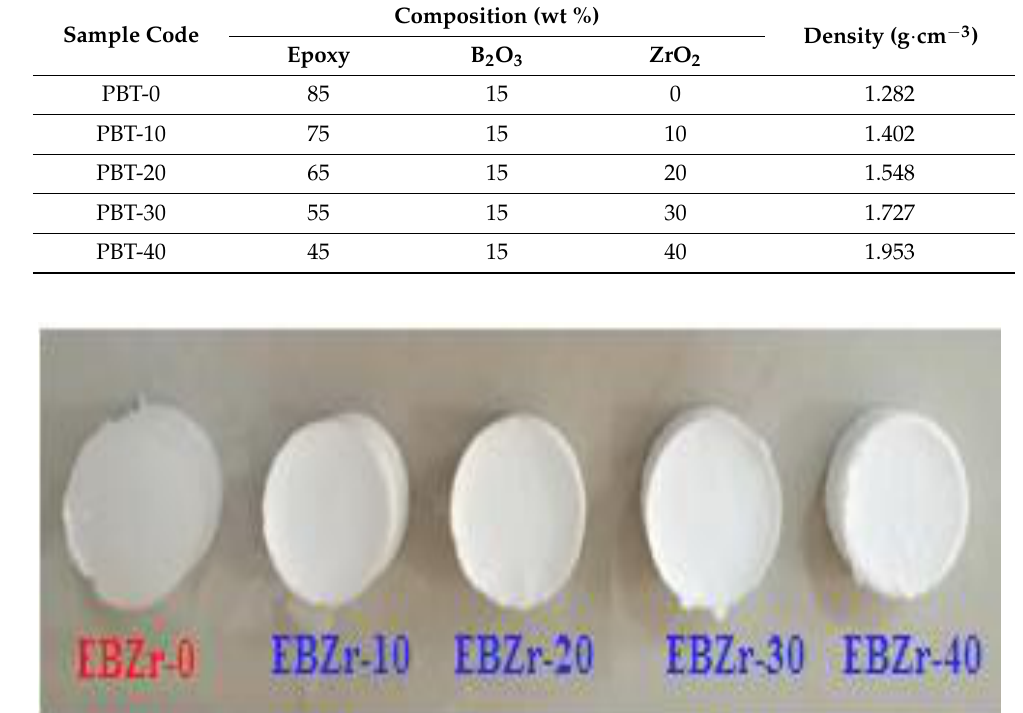
Figure 1. The prepared samples used in this study.